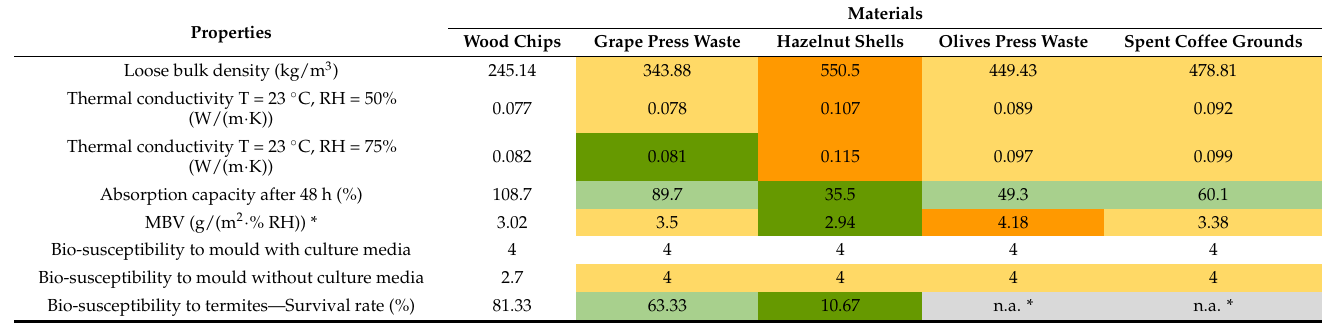
Table 10. Comparison between values of considered bio-wastes and maritime pine chips for thermal insulation